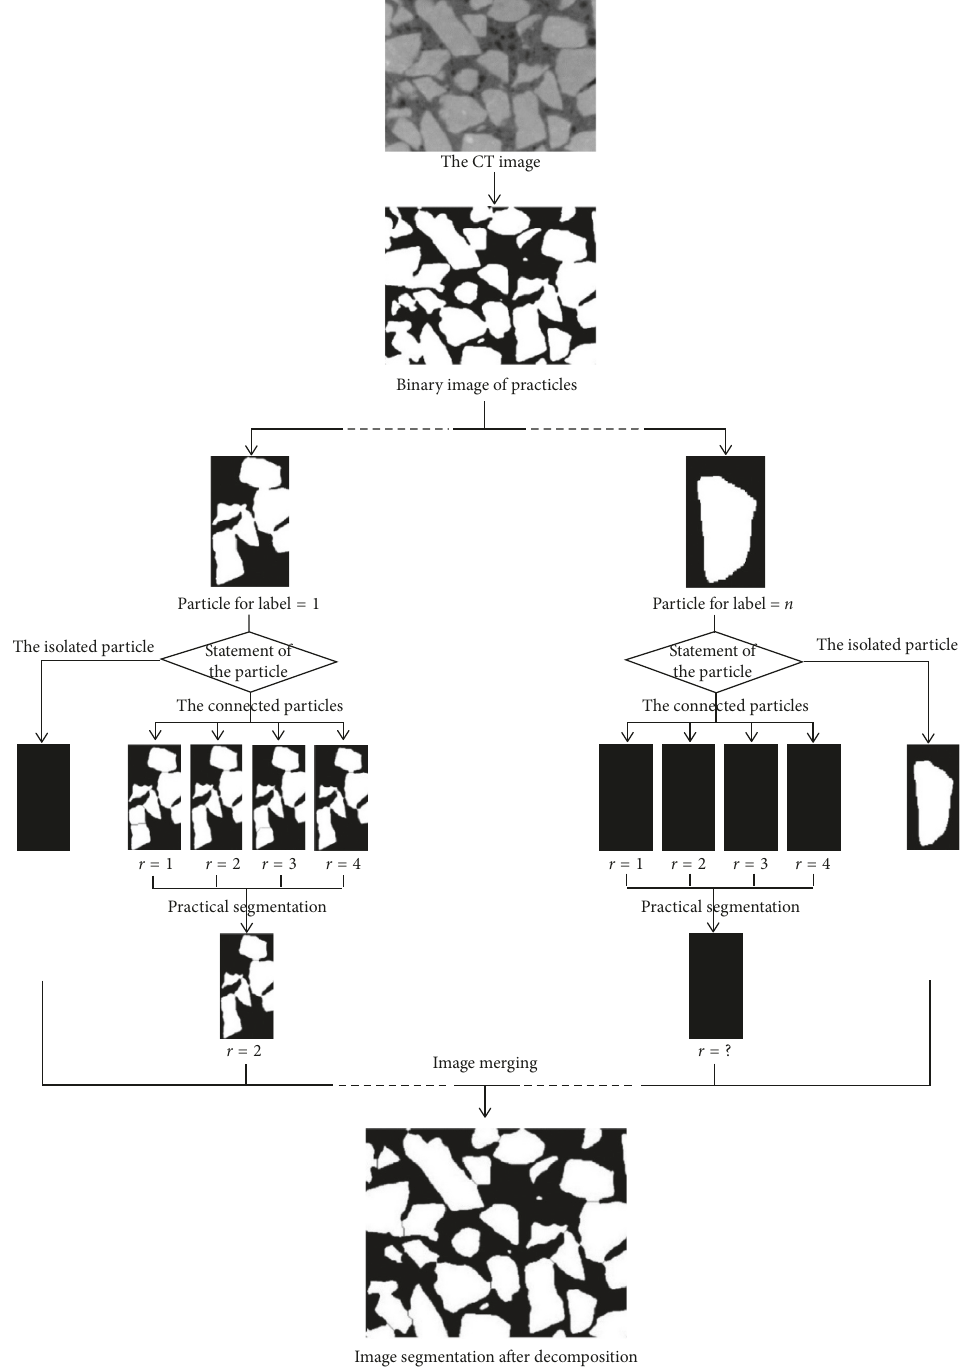
Figure 1: The algorithm flow